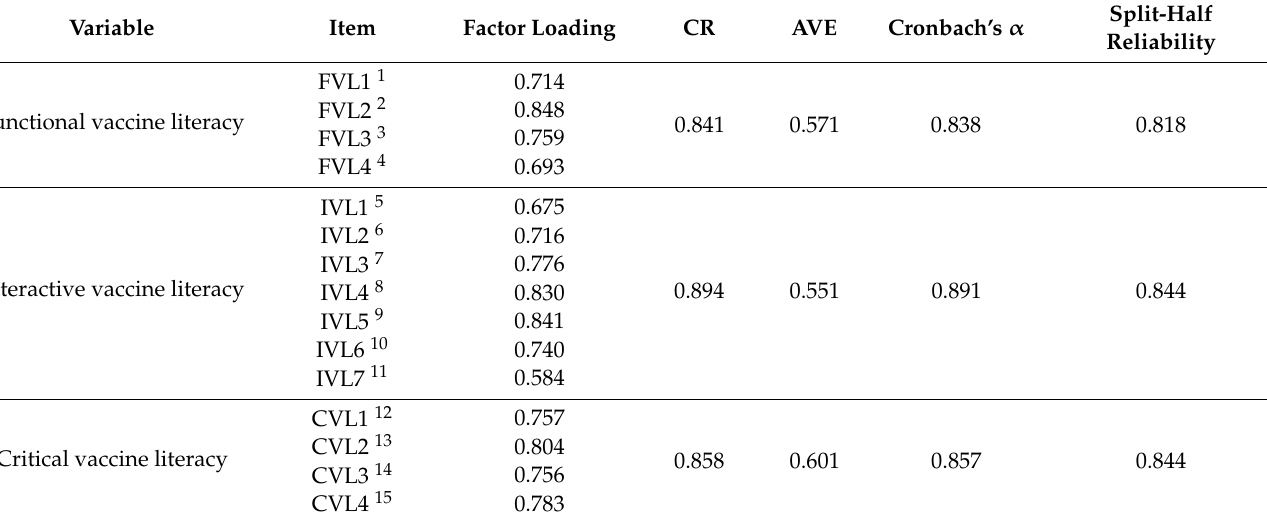
Table 1. Reliability and validity